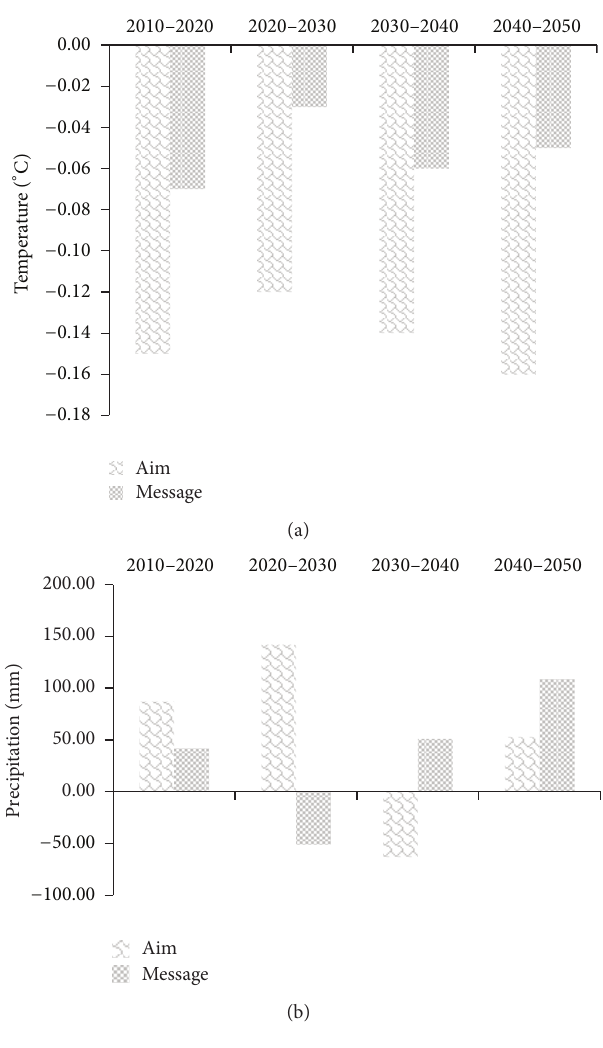
Figure 7: Climate impacts of the conversion from grassland to forestland under the RCP6 and RCP8.5 scenarios from 2010 to 2050 in Fujian province. (a) Near-surface temperature change at 2 meters height (unit: ∘ C); (b) precipitation change (unit: